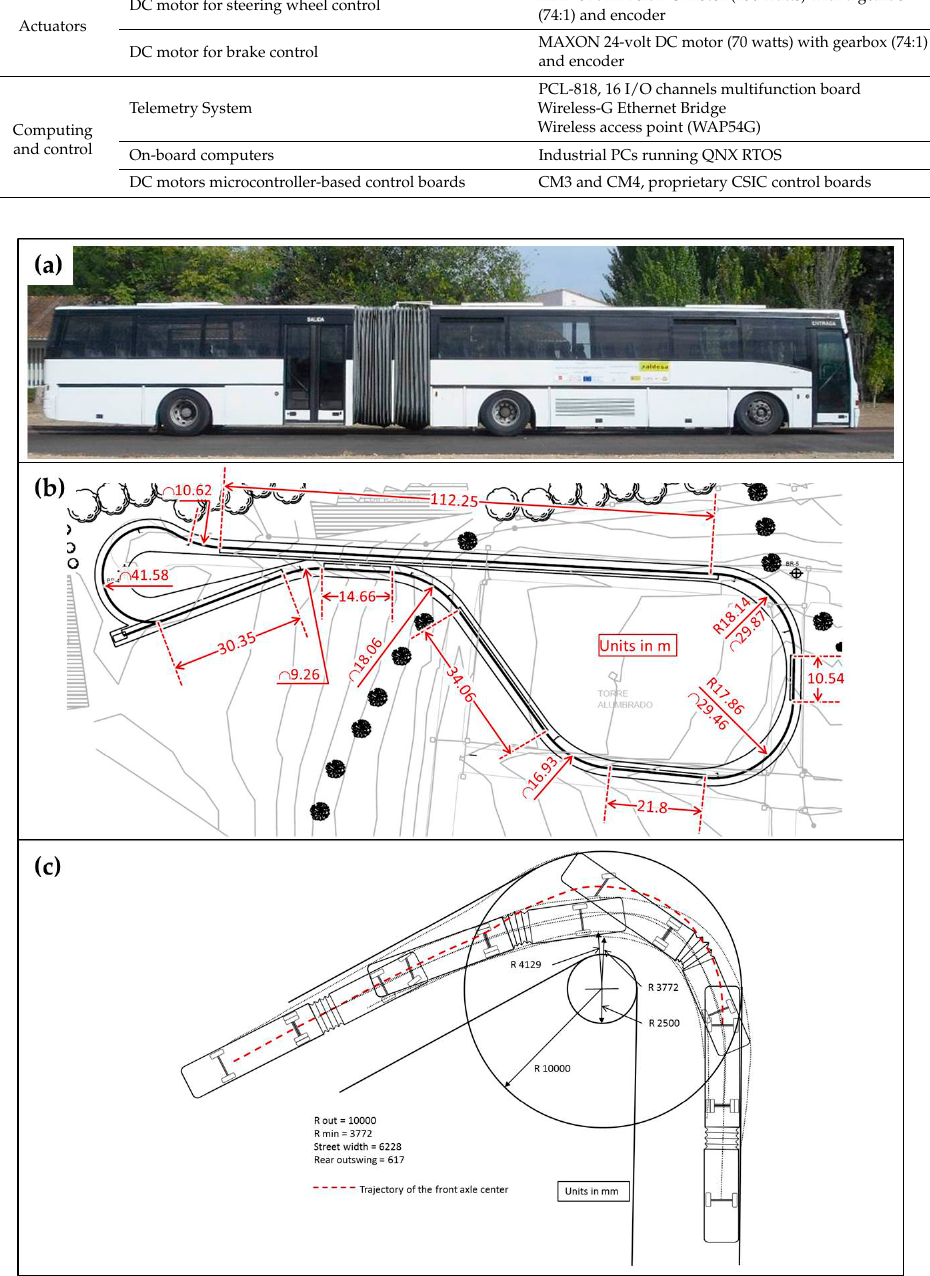
Figure 1. Experimental platform main elements. ( a ) Articulated bus Volvo B10M-ART-RA-IN; ( b ) inner road facility dimensions; ( c ) Bus trajectory analysis in one section of the path.